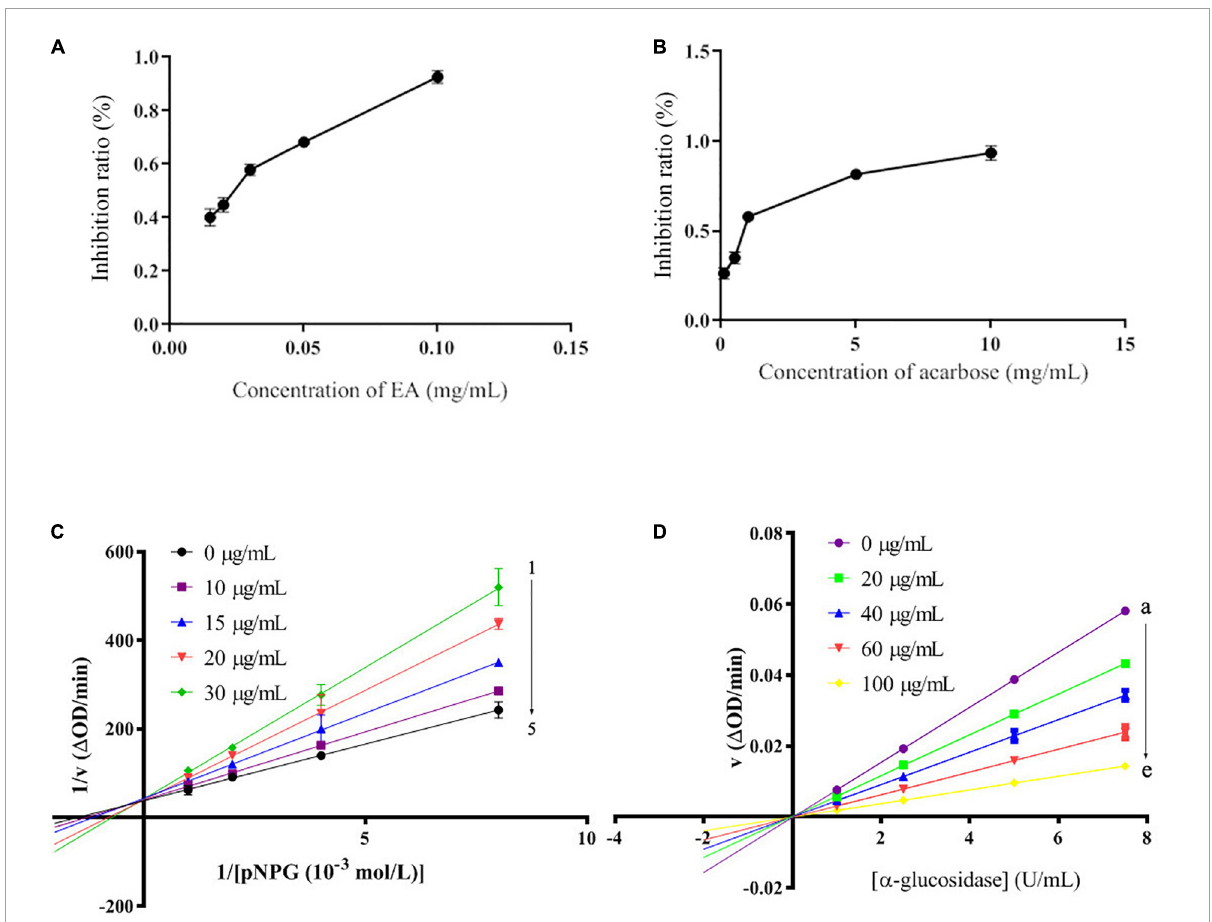
FIGURE2 The inhibitory activity of EA (A) and acarbose (B) against α -glucosidase with different concentrations. The Lineweaver–Burk plots (C) , the concentrations of EA were 30, 20, 15, 10, and 0 µ g/mL for curves 1 → 5, and the inhibitory reversibility of EA with different concentrations (0, 20, 40, 60, and 100 µ g/mL for curves a → e) against α -glucosidase (D) .